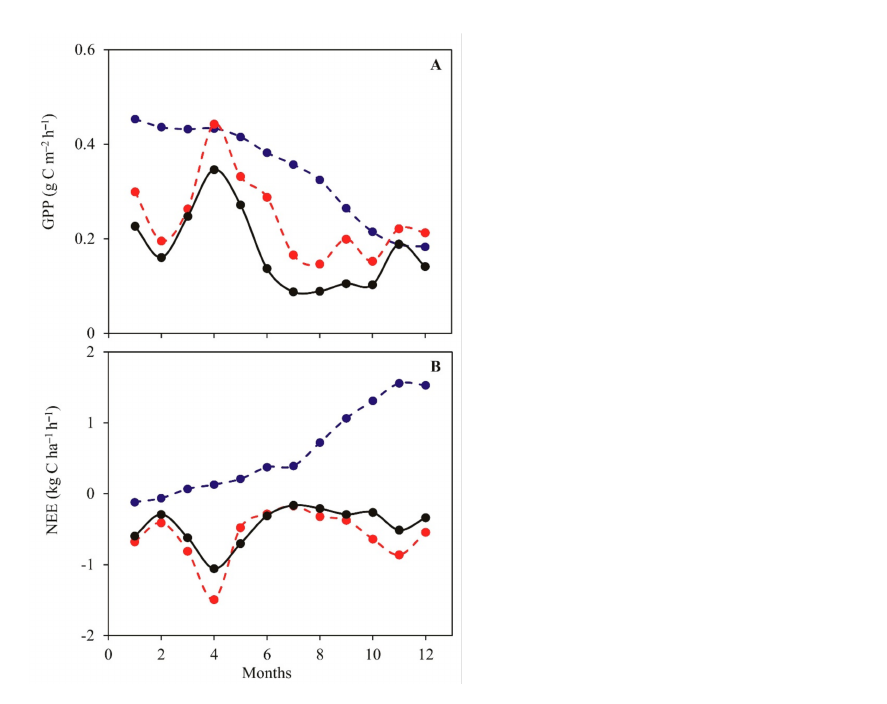
Figure 8. Simulations without calibration (dashed blue lines), simulations with calibration (dashed red lines) for the wet season (simulation M) and dry season (simulation G) and eddy covariance observations (solid black lines) of monthly mean values of CO 2 fluxes of 2014. Gross primary production (GPP; ( A )) and net ecosystem CO 2 exchange (NEE; ( B )). For details on the calibrated parameters of simulations M and G, see Table 2. Regarding NEE, carbon uptake was denoted as negative values and carbon release was denoted as positive values. For GPP, carbon uptake was denoted as positive values.